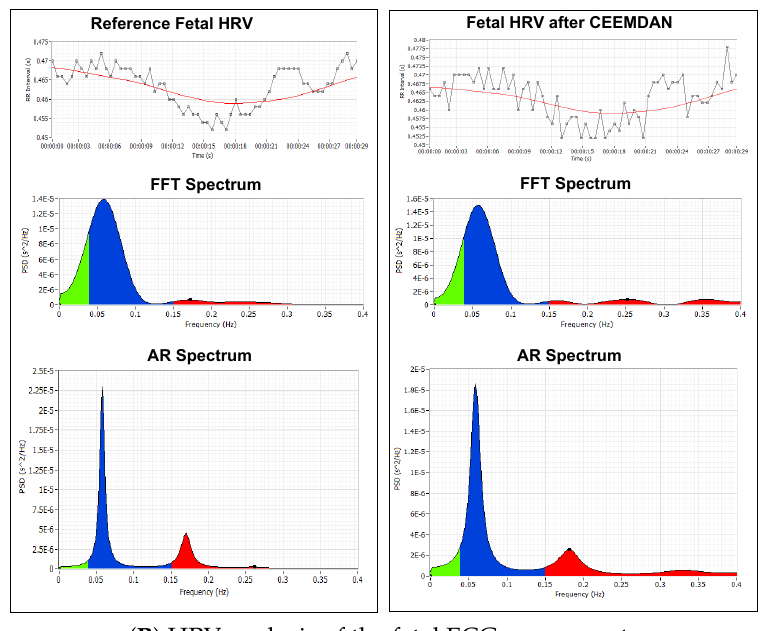
Figure 11. HRV analysis of the RR tachogram obtained from the reference signal and the signal extracted using CEEMDAN decomposition: ( A ) analysis of the maternal ECG components; ( B ) analysis of the fetal ECG